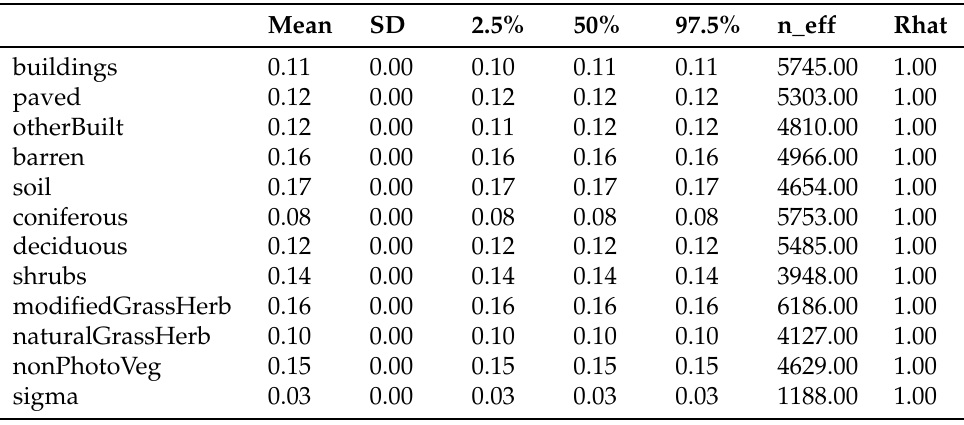
Table A3. Summary of model on effects of land cover class on on albedo.